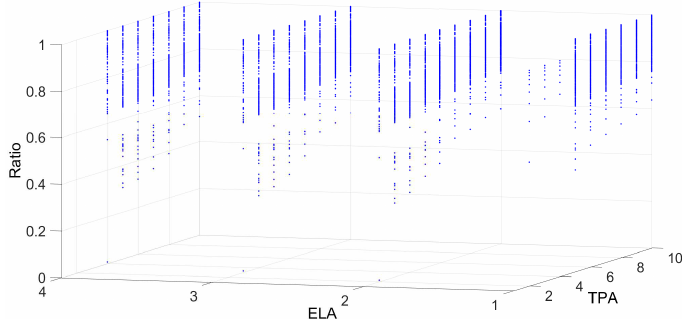
Figure 7. Outputs events as a function of the excitation level (ELA) and threshold (TPA) in Alayer . A value of TPA higher than ELA reduces the production of events, thus filtering noise but also some loss of data in the main scene appears.